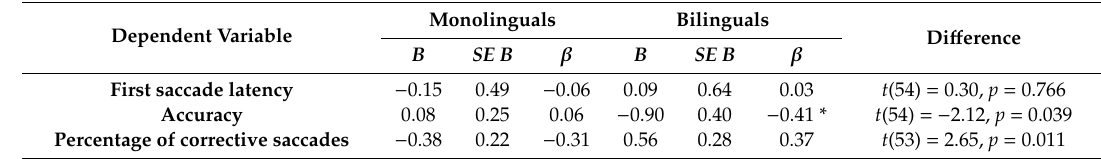
Table 4. Regression coe ffi cients and t -statistics of the relationship between trait anxiety and the dependent variables.